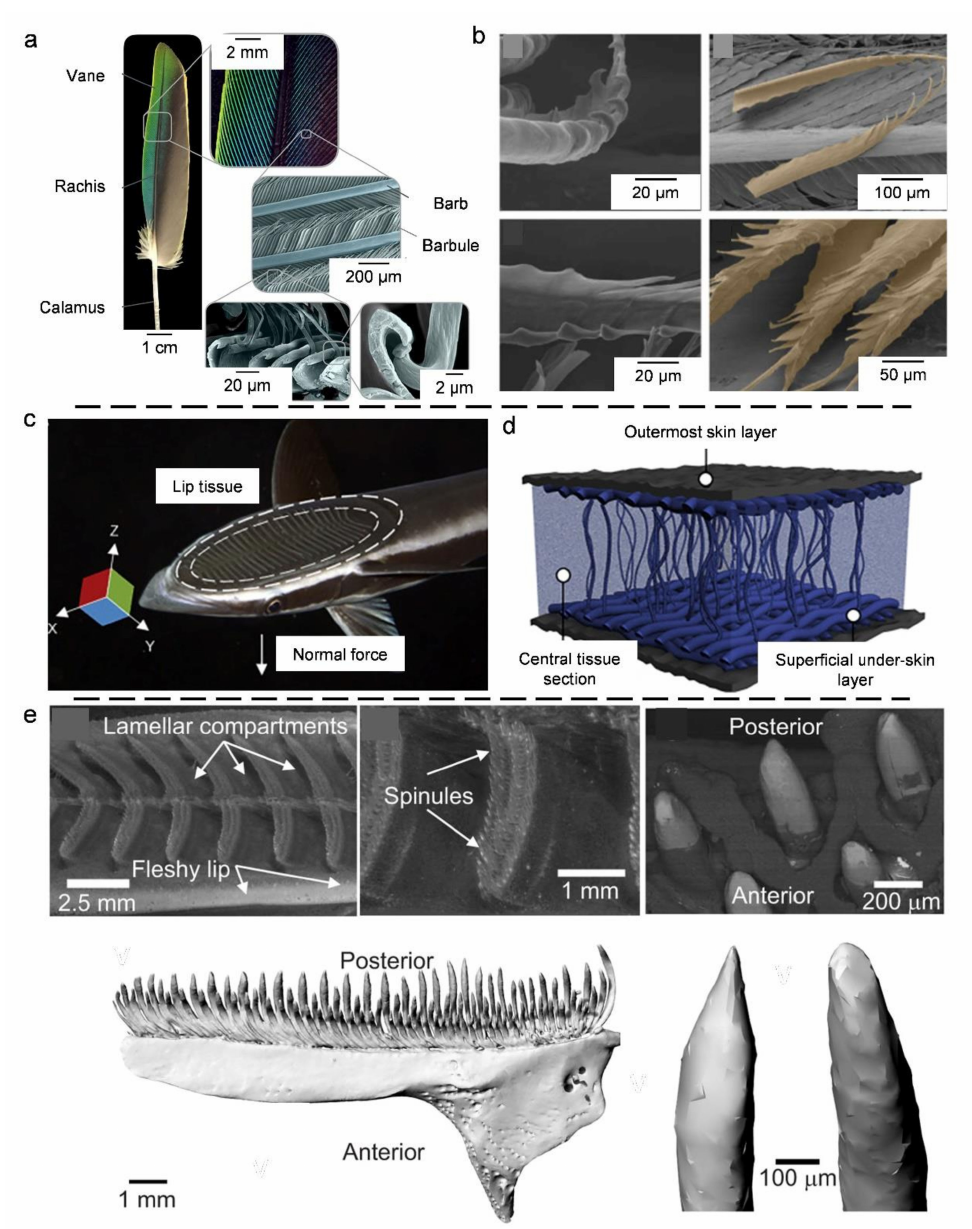
Figure 11. ( a ) The hierarchical structure of the flight feather. Reprinted with permission from [103], copyright 2017 ELSEVIER SCI LTD. ( b ) Dorsal spine on the bow barbules of feather. Reprinted with permission from [129], copyright 2018 NATL ACAD SCIENCES. ( c ) Structure and morphology illustration of the Remora soft suction disc. Reprinted with permission from [131], copyright 2020 ELSEVIER. ( d ) Schematic diagram of the three sections of outermost skin layer, superficial under-skin layer and central tissue section in suction disc. Reprinted with permission from [132], copyright 2020 ELSEVIER. ( e ) The structure of lamellae and spinules of Remora soft suction disc. Reprinted with permission from [132], copyright 2015 COMPANY BIOLOGISTS